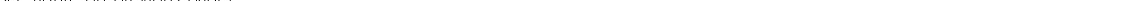
VAD-FMK (carbobenzoxy-valyl-alanyl-aspartyl-[O- methyl]- fl uoromethylketone) in DMSO. MRE11 cleavage